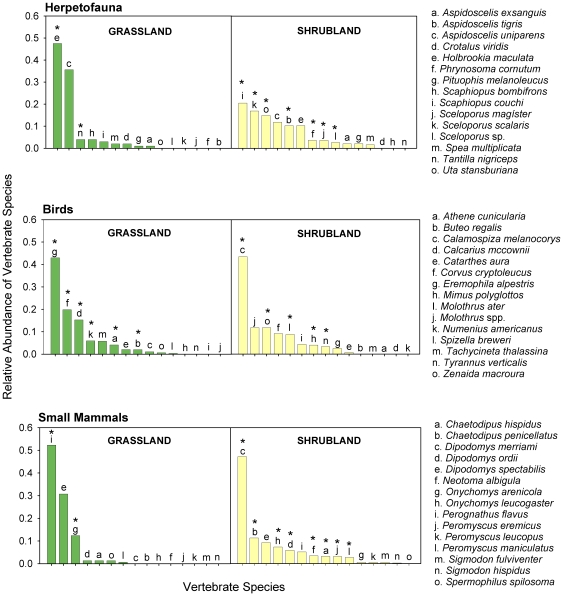
Differences in species composition between grassland and shrubland habitats.Detrended Correspondence Analysis (DCA) ordinations based on species composition of herpetofauna, birds, and small mammals. Multi-Response Permutation Procedure (MRPP) demonstrates that the species compositions of these vertebrate groups is significantly different between the prairie dog grasslands and the shrublands (1994, 1995, 1996, 2000, 2001, 2002; N = 8 for each sample period).